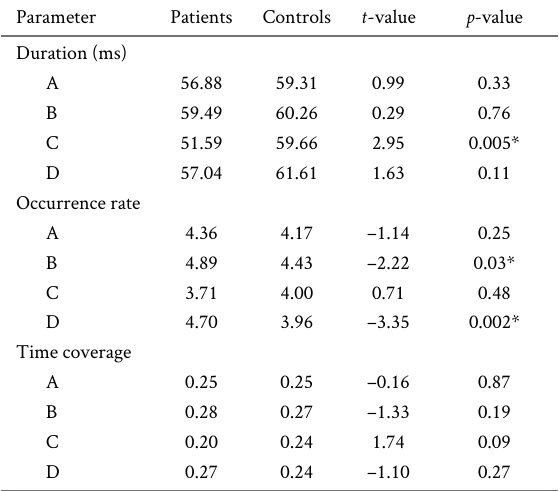
Table 2. Statistical results of microstate parameters between patients with LLA and HC controls.